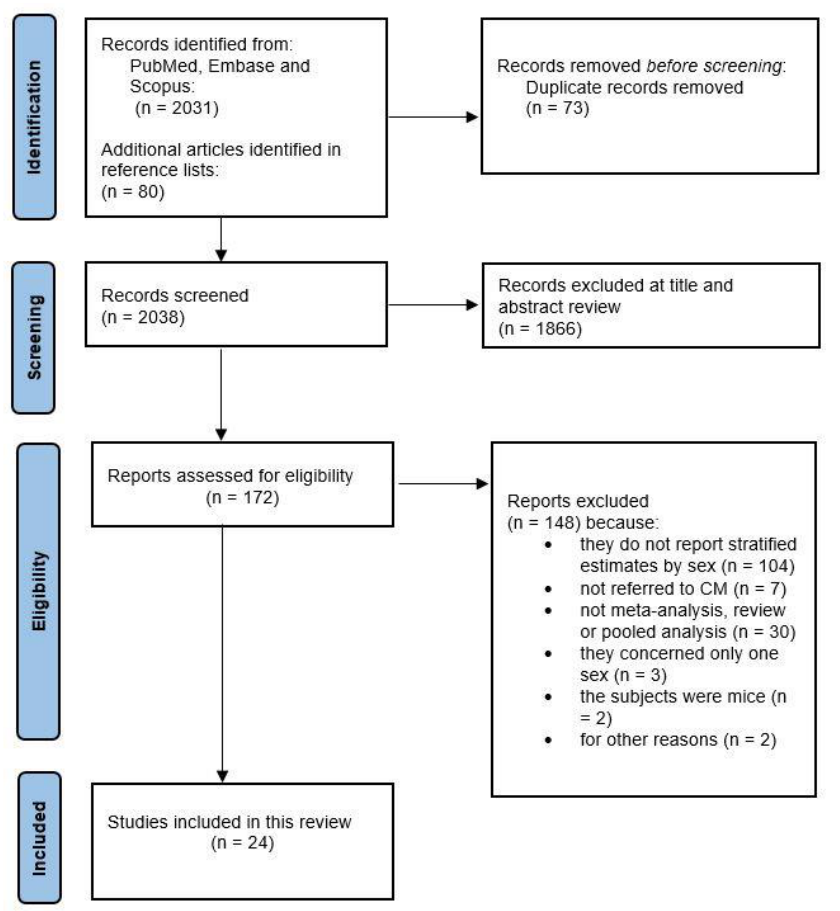
Figure 1. Flow Figure 1. Flow diagram.